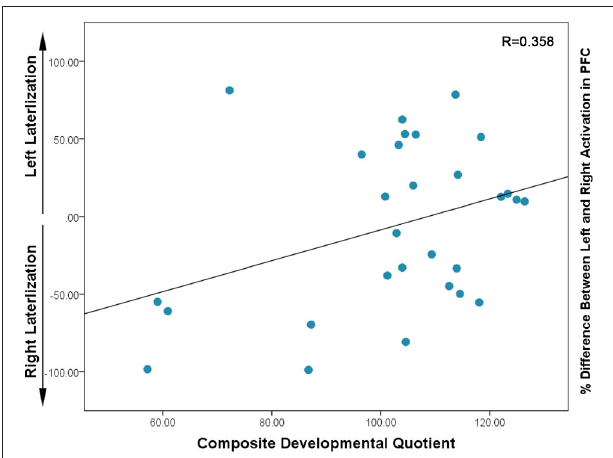
FIGURE 3 | Correlation between Composite DQ and Laterality Index (based on percent difference between left and right activation) for each subject: negative values indicate right lateralization while positive values show left lateralization. Higher values in the positive and negative direction indicate the greater activation in left or right PFC, respectively.